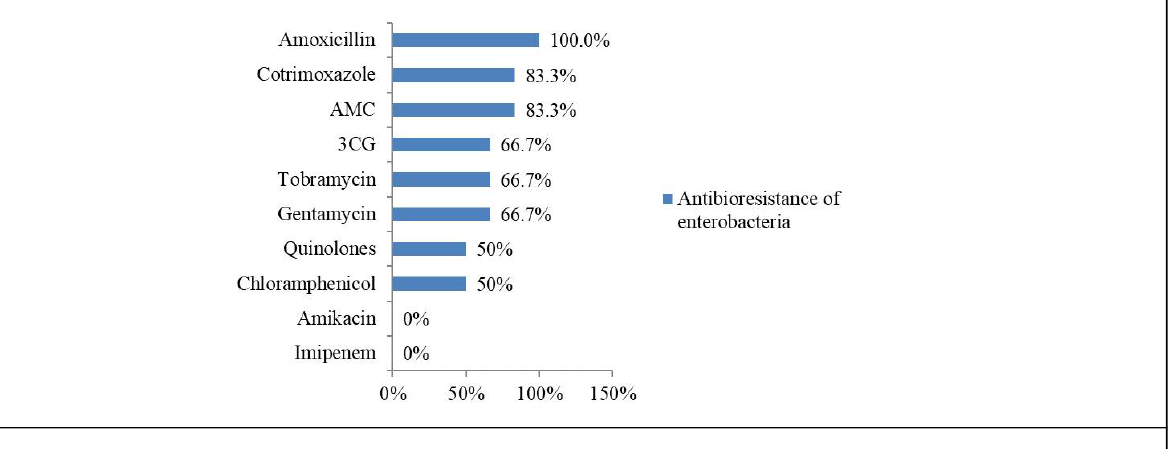
Figure 4: Antibiotic resistance of enterobacteria